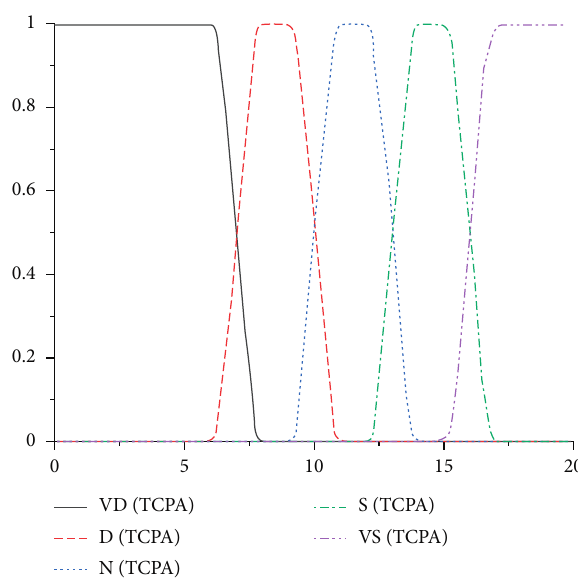
Figure 5: TCPA membership function image.